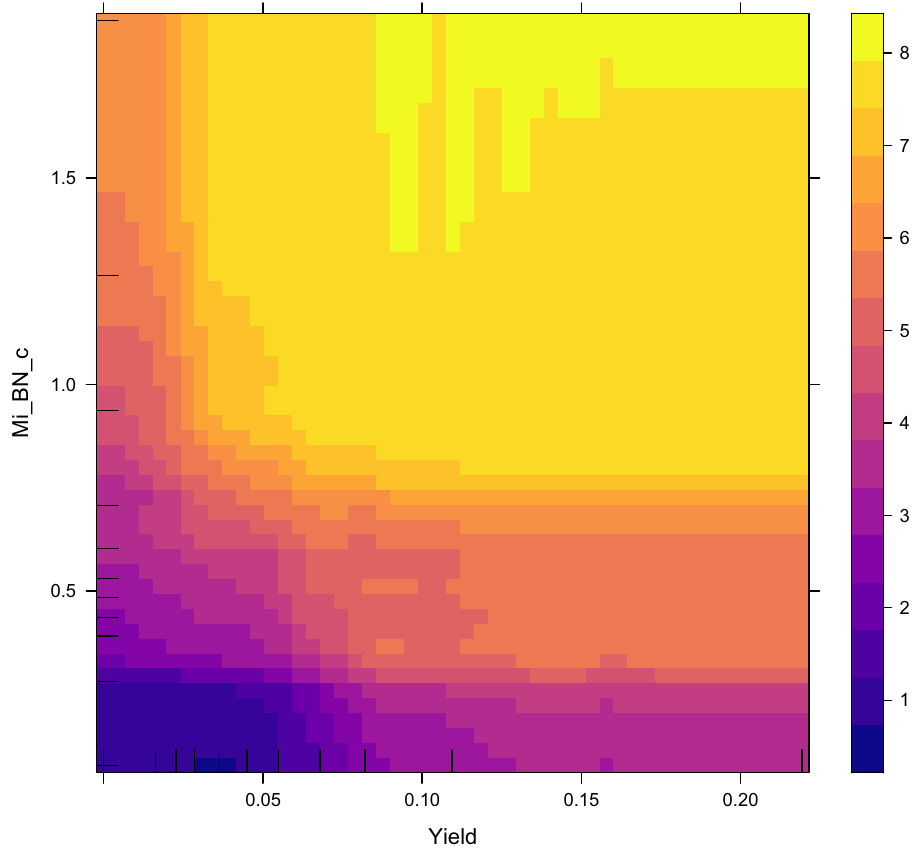
Figure 7. A two-dimensional partial dependence plot, which shows the influence of dicentric chromosomes (Yield) and corrected micronuclei (Mi_BN_c) on reconstructed dose in the random forest model. The plot shows that low values of both Yield and Mn_BN_c are associated with low reconstructed doses (blue), whereas high values of Yield and Mn_BN_c are associated with high reconstructed doses